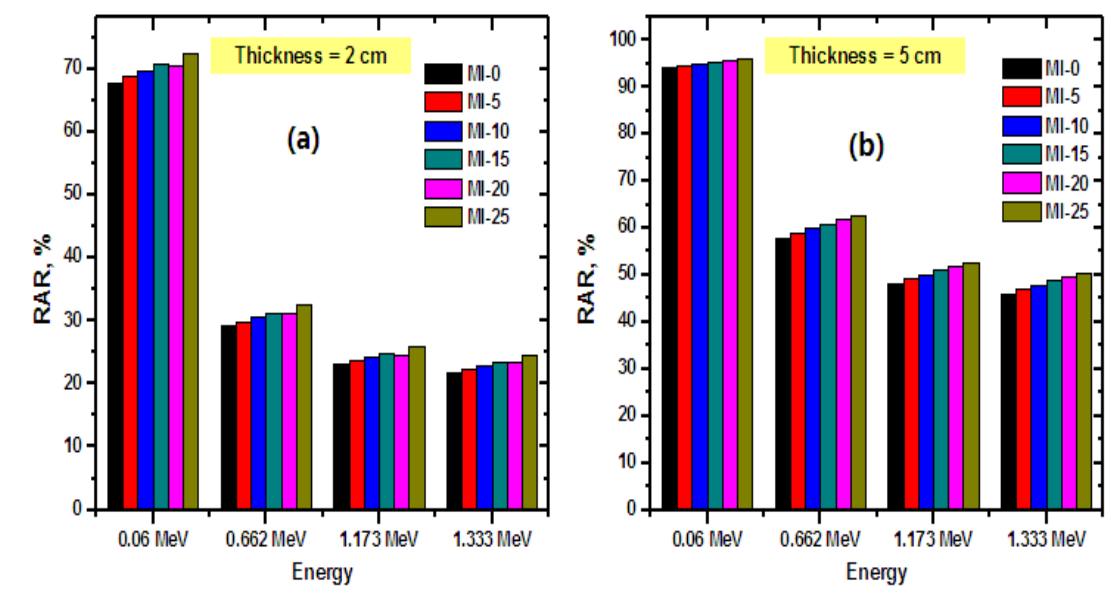
Figure 9. The relation between the RAR and the energy for prepared sample with ( a ) 2 cm and ( b ) 5 cm thickness.